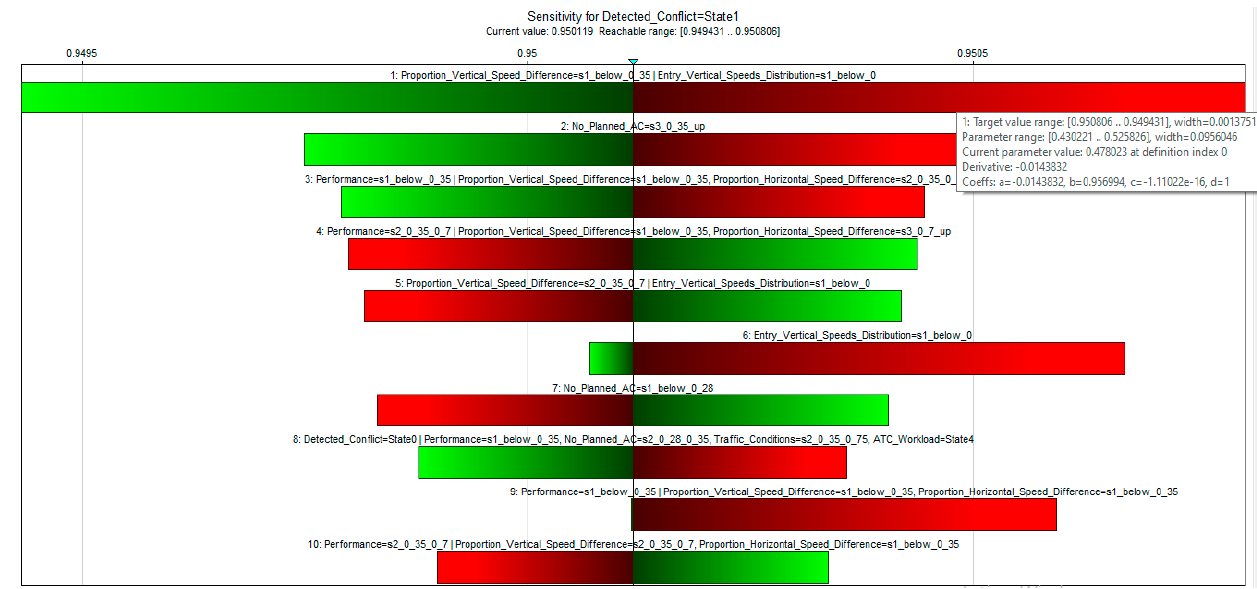
Figure 5. Tornado diagram .